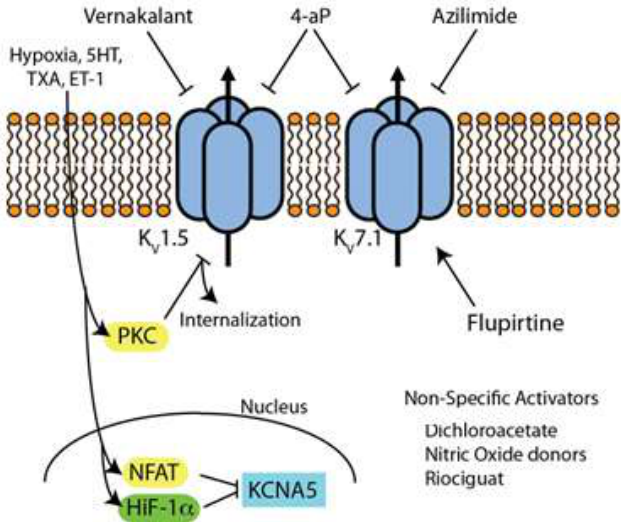
Figure 3. Simplified schematic representation of pathways and small molecules involved in the regulation of the Kv channel; 5HT, serotonin; TXA, thromboxane; ET-1, endothelin-1; PKC, protein kinase C; NFAT, nuclear factor of activated T-cells; HiF-1 α , hypoxia-inducible factor-1 α , 4-AP, 4-Ami- nopyridine.